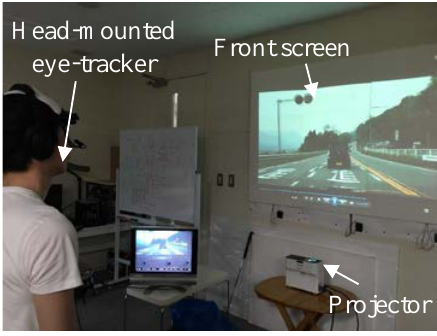
Figure 2: Experimental apparatus for eye tracking.